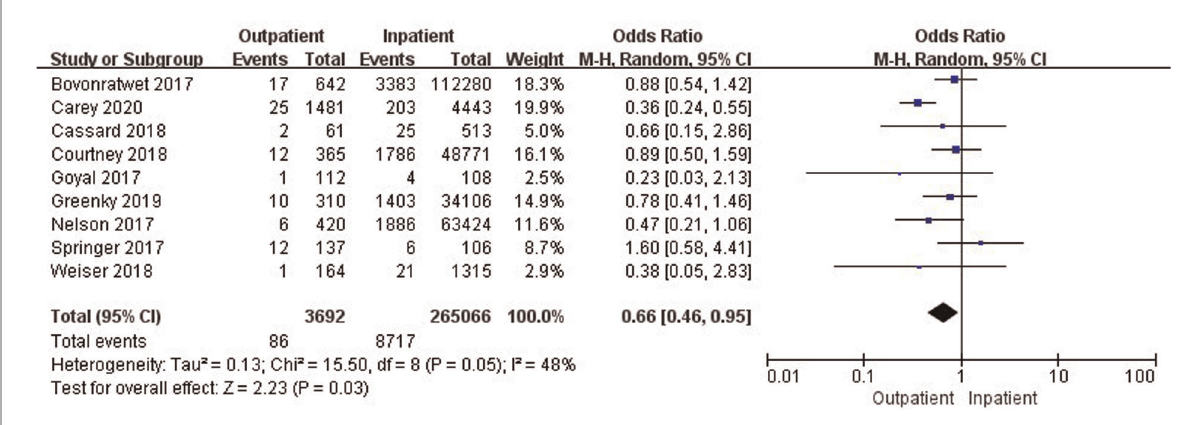
FIGURE 4 Comparison of 30-day readmissions between outpatient and inpatient TJA.